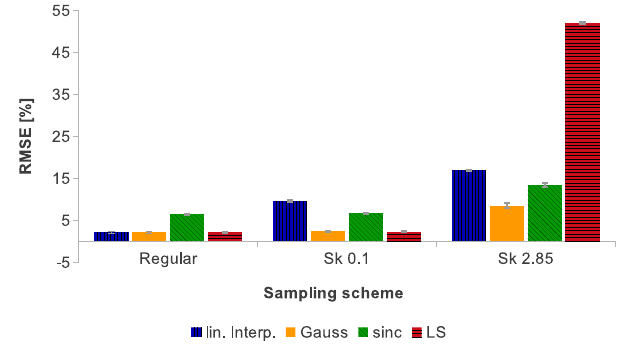
Fig. 8. Mean RMSE for the ACF estimation (lag 1) using linear interpolation, Gaussian or sinc kernel or the inversion of the LS Periodogram of time series from AR(1) processes (cf. Eqs. 15), given for regular, gamma-distributed and mildly irregular (skew- ness sk=0.1) resp. very irregular (sk=2.85) sampling. Errorbars give the standard deviation of the estimate, calculated using 1000 bootstrap